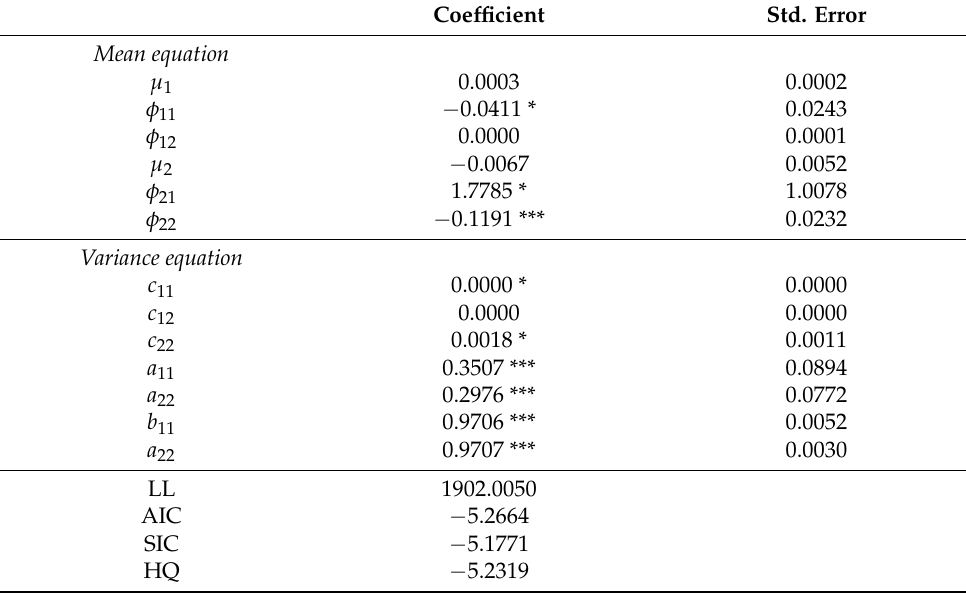
Table 2. Estimation of the diagonal BEKK-GARCH model. Coefficient Std.